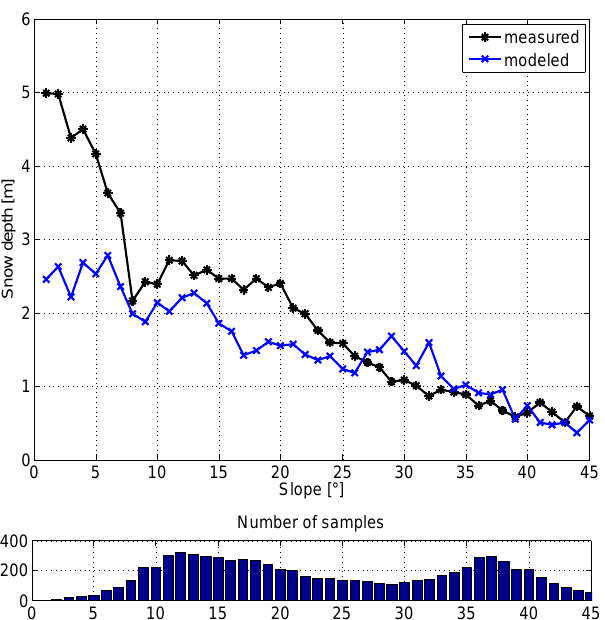
Fig. 7. Snow/deposition depth as a function of slope angle. The black line corresponds to measured snow depths, h s , while the blue line refers to deposit depths, h d , from simulation ] 1. We assume h s ∼ = h d . Note that, for steep slopes, this approximation may not hold, and thus h d is probably overestimated (see Sect.